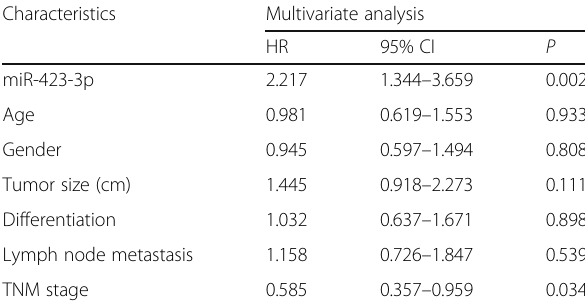
Table 2 Multivariate Cox analysis of clinical parameters in relation to overall